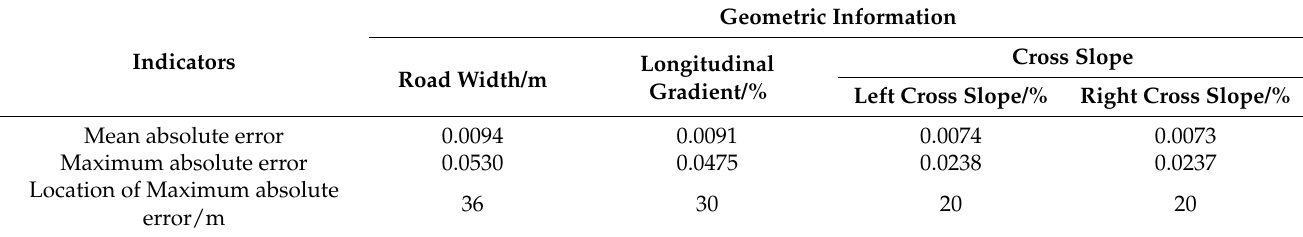
Table 4. Comparison between extracted and manually measured geometric information.